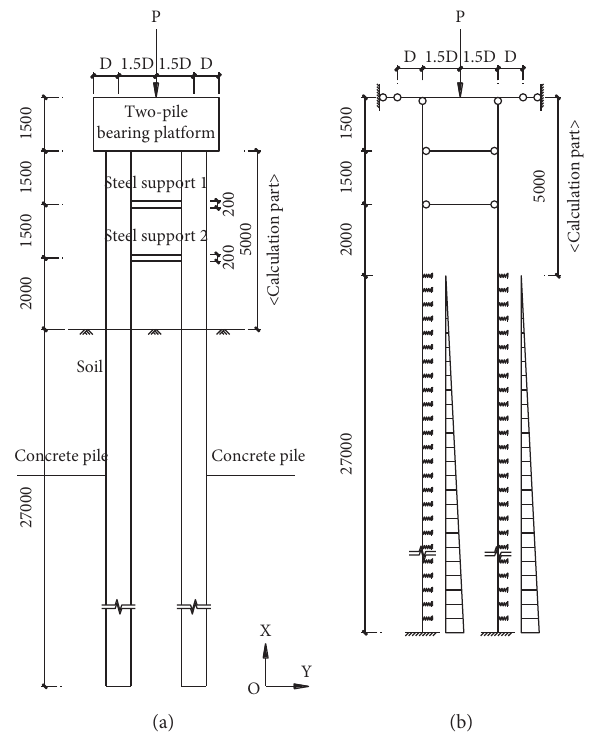
Figure 4: Analysis model and simplification. (a) Geometric model. (b) Mechanical model.